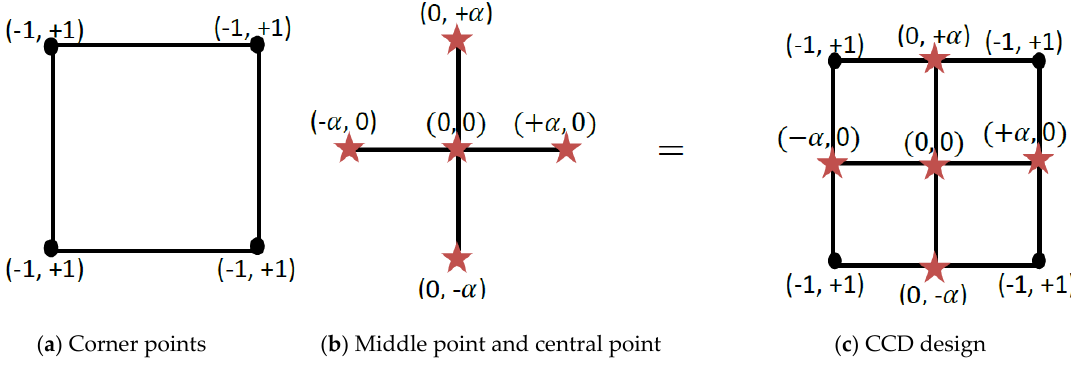
Figure 2. Central composite design (CCD) module (face-centered). ( a ) Corner points, ( b ) middle, and central point ( c ) CCD design.